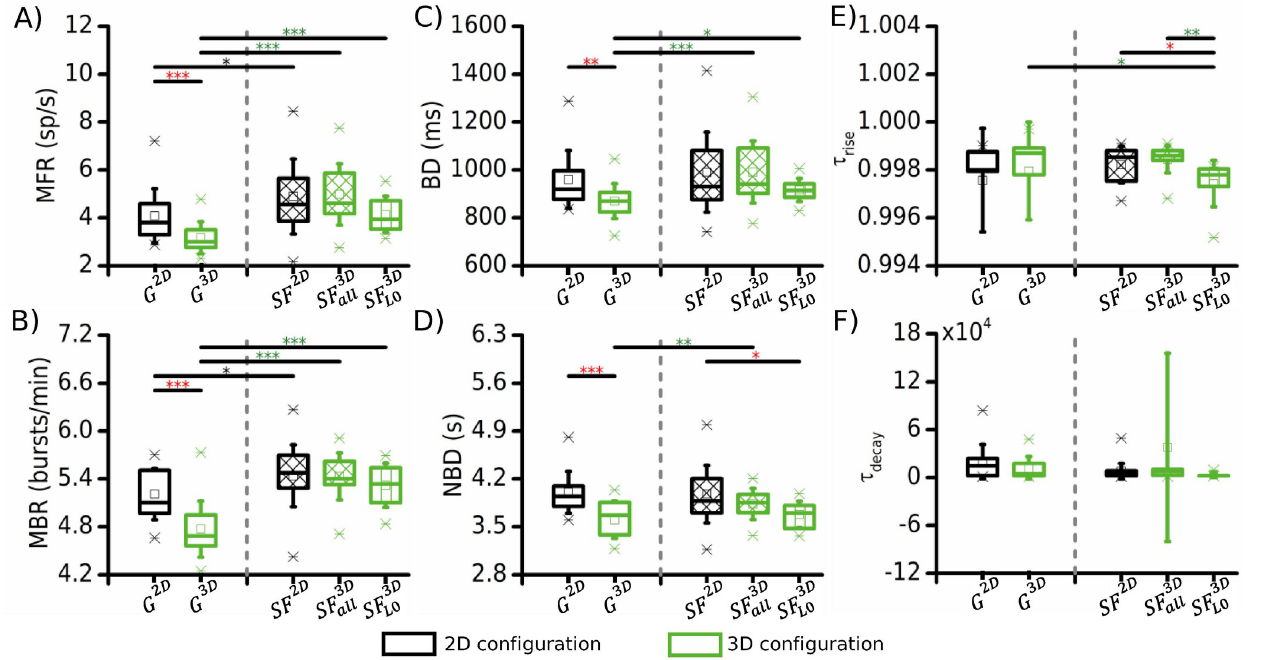
Fig 5. Effect of the implemented single layer connectivity on the electrophysiological activity of 3D networks. The 3D constructs (green boxes) with a SF connectivity either only in the readout layer ( SF 3 D ) or in every layer ( SF 3 D ) were compared to the Gaussian ( G 3 D ) reference topology. Similarly, the 2D L 0 all controls (black) implemented a SF ( SF 2 D ) and a Gaussian ( G 2 D ) connectivity, respectively. (A) Mean firing rate, ( B ) mean bursting rate, ( C ) burst duration, ( D ) network burst duration, temporal time constants of the ( E ) rise and ( F ) decay phases of the network bursts. Black and green boxes stand for 2D and 3D networks, respectively. The asterisks are color coded to indicate the statistical differences between 2D and 3D networks ( red ), 2D networks with different connectivity ( black ), and 3D networks with different connectivity ( green ). ( � refers to 0.01 < p < 0.05, �� 0.001 < p < 0.01, ��� p < 0.001, Kruskal-Wallis non- parametric test).